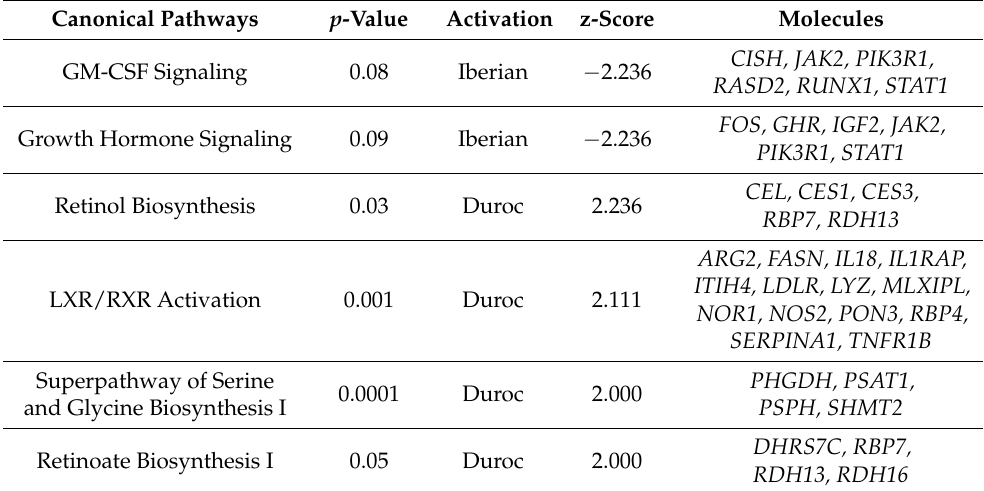
Table 5. IPA-based list of pathways in the set of DEGs conditional on breed ( p -value < 0.1, z-score > 2 or < −